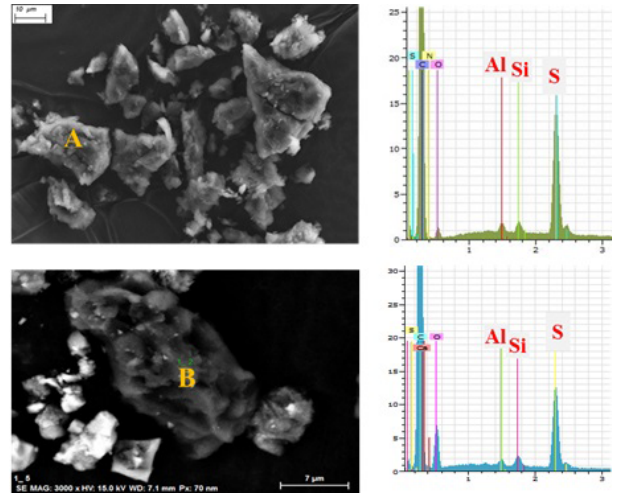
Figure 6. Scanning electron microscopy (SEM) images and energy dispersive X-ray (EDS) spectra of (a) authentic delayed petcoke particles and (b) a petcoke particle found in a PAS-DD sample col- lected at AMS5. Al, aluminum; Si, silicon; S,